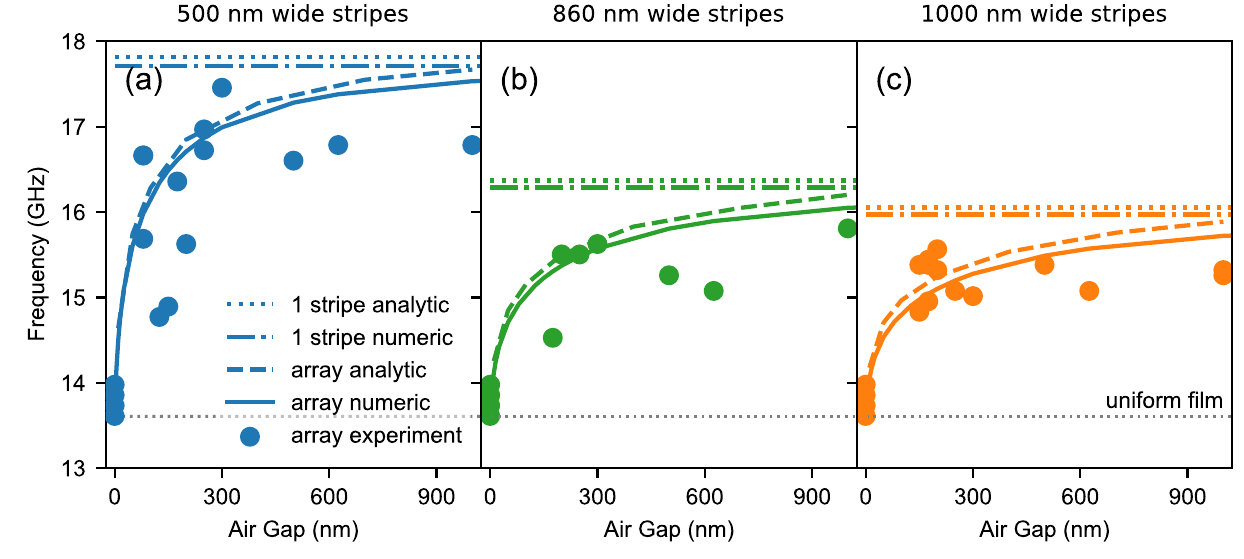
Figure 2. The results show the fundamental mode frequency for individual structures, depending on the width of the air gap (separation) between magnetic stripes with the widths of ( a ) 500 nm, ( b ) 860 nm, and ( c ) 1000 nm. In subplots ( a ), ( b ), and ( c ), the results of measurements with the TR-MOKE method are represented by points. These results are compared with the solid and dashed lines’ numerical and semi-analytical calculations. The dotted grey line shows the lower frequency limit corresponding to the fundamental mode frequency of the layer (the result of the calculation). The dotted (dash-dotted) lines show the frequency limits for individual stripes of given widths, which is the upper-frequency limit of the tested systems—sequences of stripes of a given stripe width—the result of numerical (semi-analytical) 60 ◦ out of the normal to the plane in-plane bias magnetic field of magnitude µ 0 H 0 = 0.15 T tilted at an angle θ = ( z -axis), in the direction of the stripes ( y -axis). In all calculations, we have assumed the saturation magnetization 176 rad GHz/T. M S 1342 kA/m and the exchange constant A exch 13.6 pJ/m. The gyromagnetic ratio is γ = = − = Those values come both from measured values of uniform CoFeB film, as well as from matching the frequency value for a homogeneous CoFeB layer in numerical calculations with the value obtained in measurements with TR-MOKE (the result for a uniform layer is presented in Supplementary information A). The same fundamental mode frequency could be obtained for a uniform layer using Kittel’s ferromagnetic resonance (FMR) frequency γµ 0 √ ( H 0 sin θ)( H 0 sin θ M S ) . The TR-MOKE experiment was performed as presented in Fig. 1d formula: f 2 π = + and described in “Methods-measurements”. The signal measured in time was then subjected to postprocessing (described in Supplementary information A), culminating in the calculation of the Fourier transform of the measured and processed signal. With this procedure, we are able to obtain the experimentally measured frequen- cies for each of the fabricated structures. The numerically calculated FMR frequency for the CoFeB layer is equal to 13.6 GHz. The FMR frequencies obtained experimentally by TR-MOKE are in the range of 13.6 up to 13.95 GHz. Differences may be due to the quality of the samples measured, the quality of the laser in the pump-probe experiment, and other factors. It follows that measurement uncertainties of half a gigahertz are expected, even for simple structures. The value calculated for uniform CoFeB film is marked in Fig. 2 by a dotted grey line. After these preliminary studies, we performed (by TR-MOKE) the measurements of magnetization dynamics in all the fabricated periodic structures with stripes of the widths w 500, 860, 1000 nm, separated by the air = gaps with the widths g 125, 150, 175, 200, 250, 300, 500, 625, 1000 nm. To demonstrate the impact of the width = of the stripes on the interactions between the neighboring stripes in periodic structures, we have plotted the frequency of the fundamental mode in the dependence on the air gaps’ width g (dots in Fig. 2). These dependen-